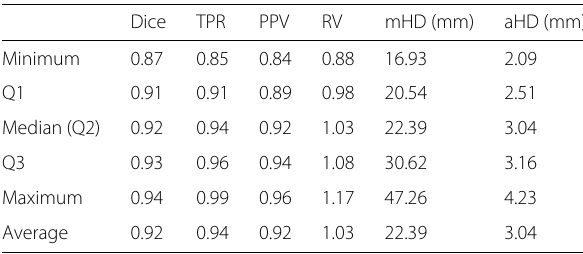
Table 2 Evaluation of total liver segmentation for all cases (test set and training set were pooled together); dice coefficient, true positive ratio, positive protective value , relative volume, and maximum and average of Hausdorff distances for manual and automatic liver segmentation